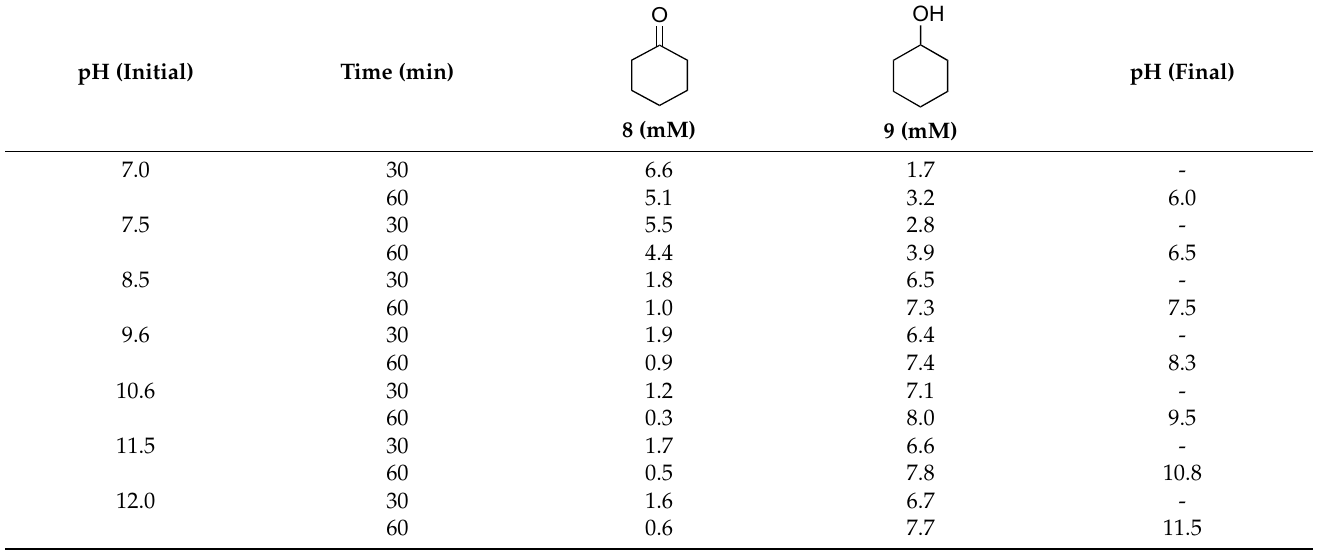
Table 1. Photolysis (low-pressure Hg lamp, 5.5 W) of N 2 -saturated aqueous solutions of cyclohexanone ( 8 , 8.3 mM) containing cysteine (18.3 mM) with formation of cyclohexanol ( 9 ) at different irradiation times and pH. 1.